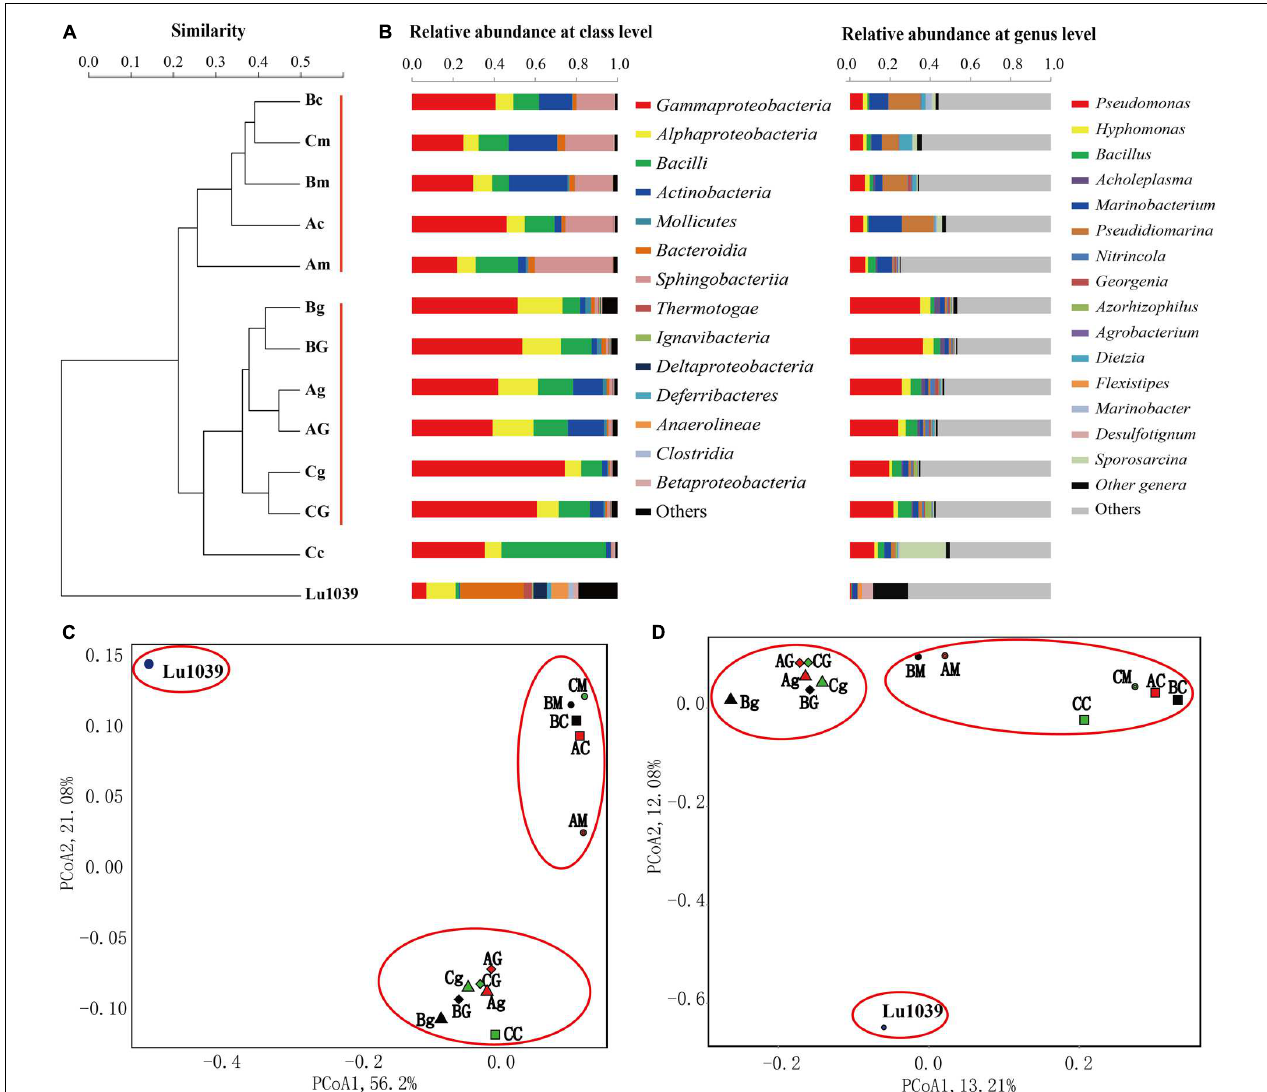
FIGURE 8 | Clustering (A), histogram (B), weighted Unifrac PCoA (C), and unweighted Unifrac PCoA (D) analysis of the microbial communities in water samples stimulated by nutrients or in combination with Bacillus subtilis M15-10-1. A: microcosm containing nutrients; B: microcosm containing nutrients and crude oil; C: microcosm containing nutrients, crude oil, and Bacillus subtilis M15-10-1; G: glucose; g: glycerol; m: molasses; and c: corn steep